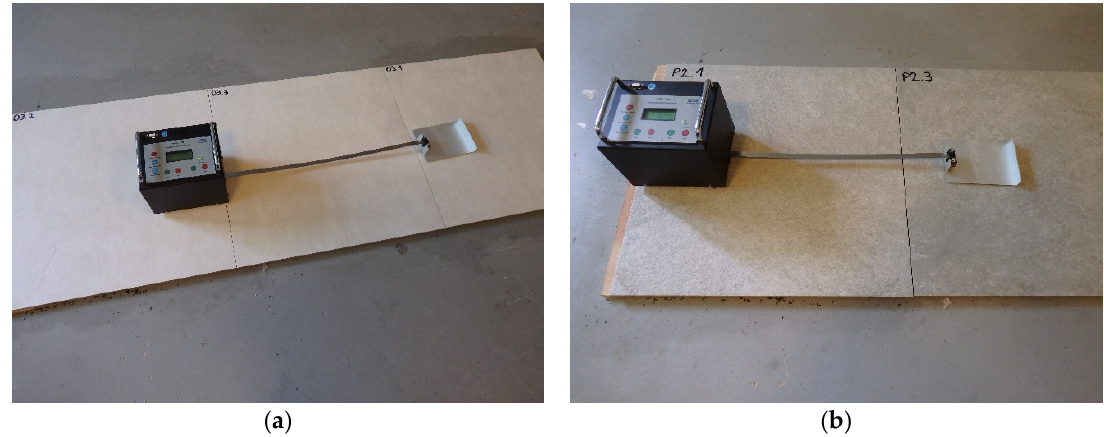
Figure 4. The sliding friction coefficient test on ( a ) S5 and ( b ) S4 samples in dry conditions.